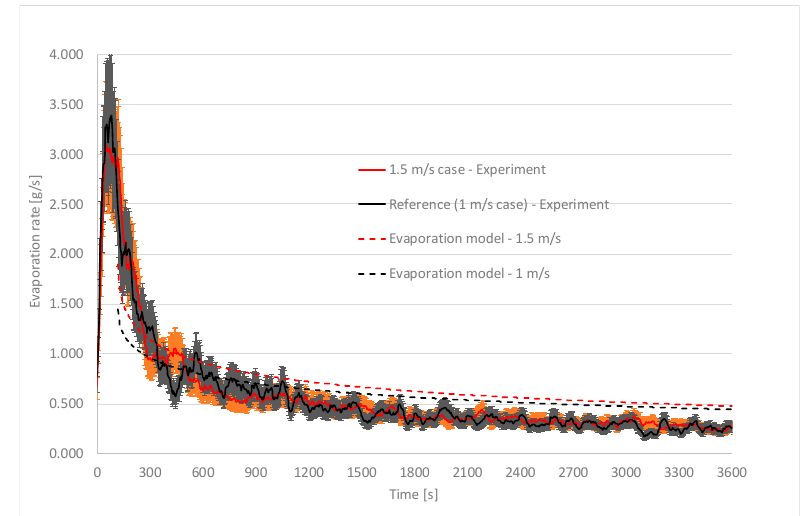
Figure 14. Evolution of evaporation rate for two velocity configurations.